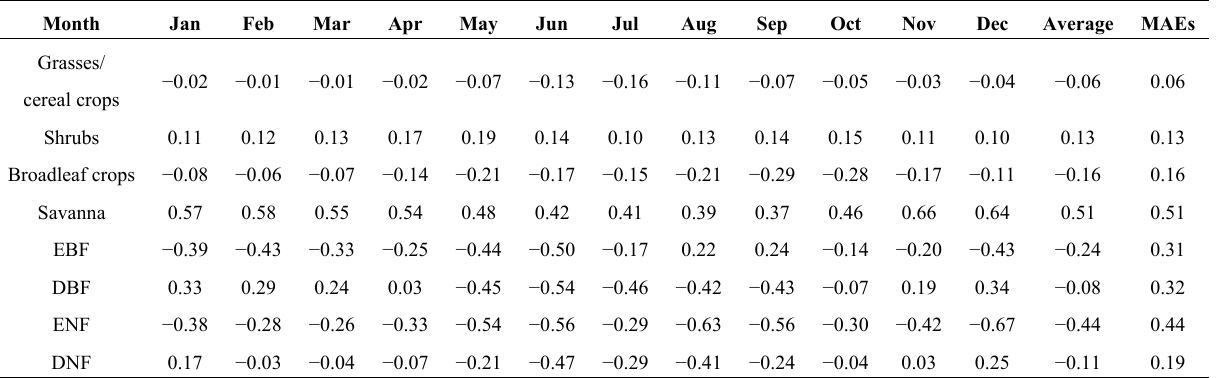
Table 3. Monthly average of the misclassification induced LAI errors (MIEs) for the eight primary biome types (2003 − 2009). The mean absolute errors (MAEs) are calculated from the average of the absolute monthly